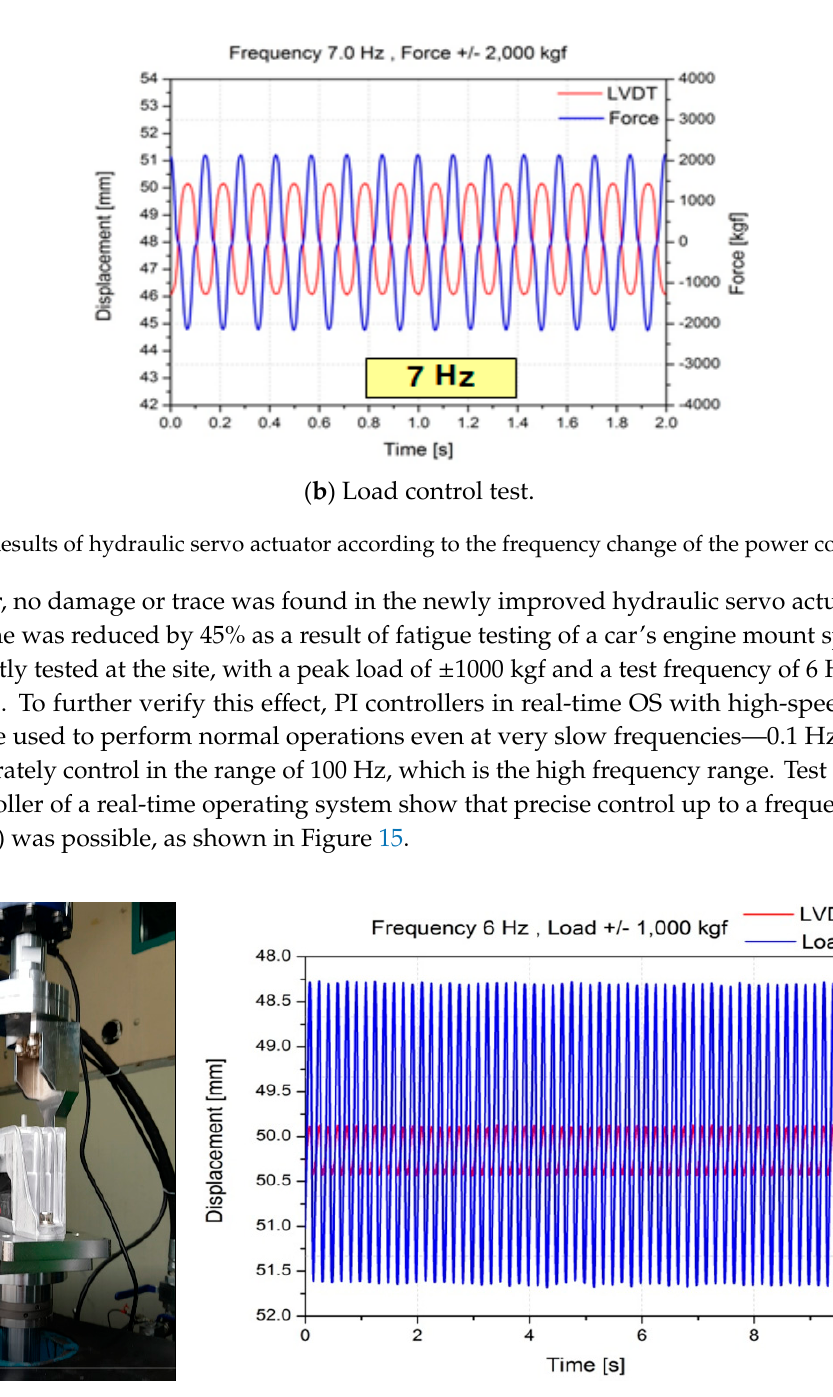
Figure 14. Fatigue life test of engine mount spring with large eccentric load (106 cycles).